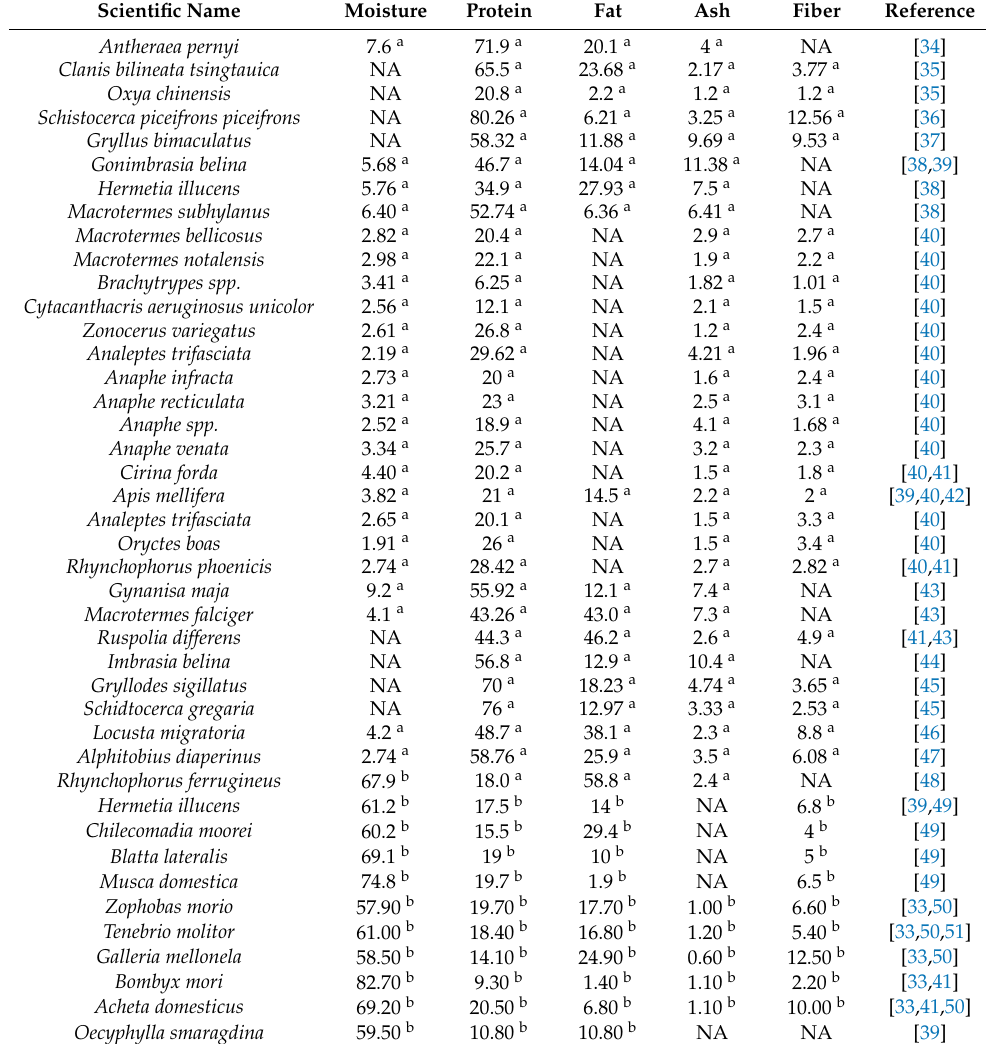
Table 1. Proximate composition of insect